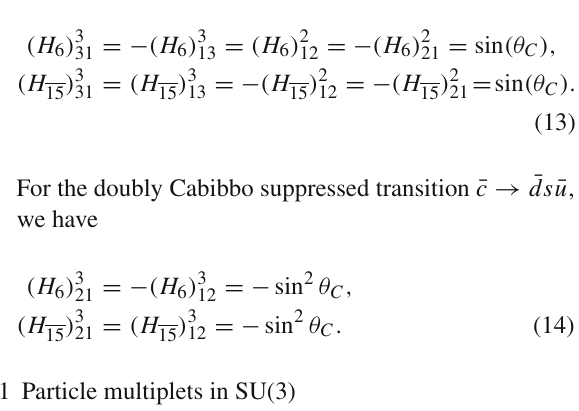
Table 1 The split mass of pentaquark P cc ¯ qqq with the S-wave in the parity of J P = 1 is the isospin of pentaquark Pentaquark ( J P , I ) Mass Threshold This work ChEFT [19] CMI [15] QCDSR [20] − , cc ¯ snn ( 1 0 ) 4 . 092 ± 0 . 298 3.957 4.702 – (cid:6) ccq ¯ 2